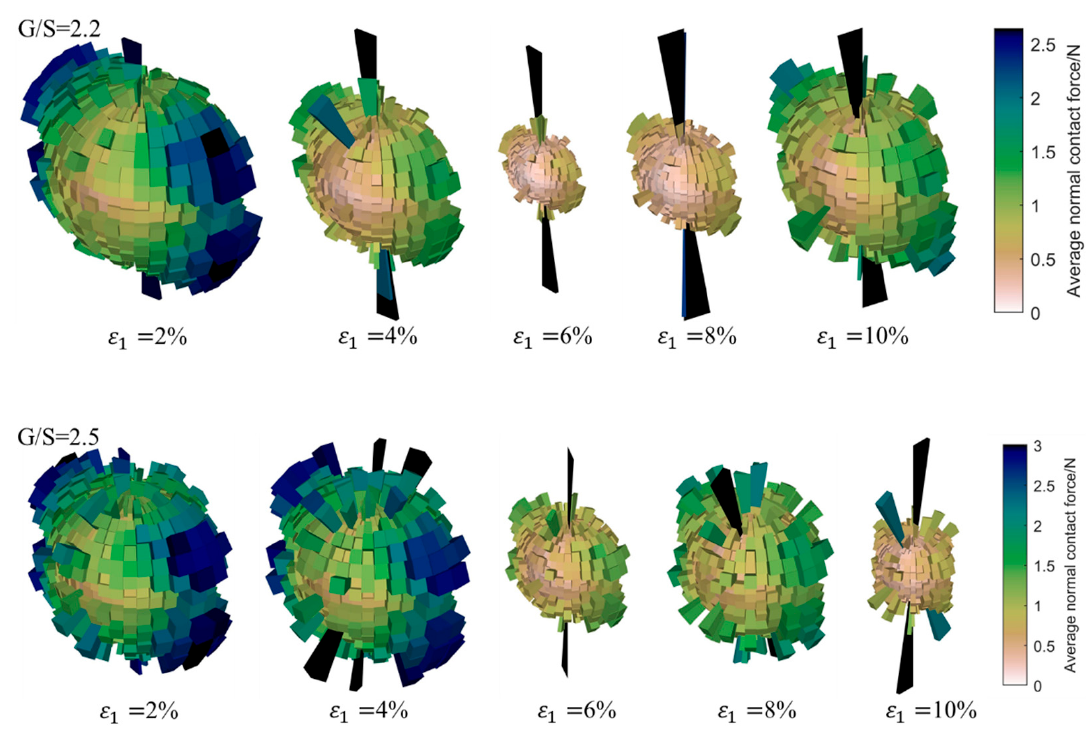
Figure 16. Three-dimensional rose diagrams showing the evolution of tangential contact forces during the shearing process for specimens with different G/S values.